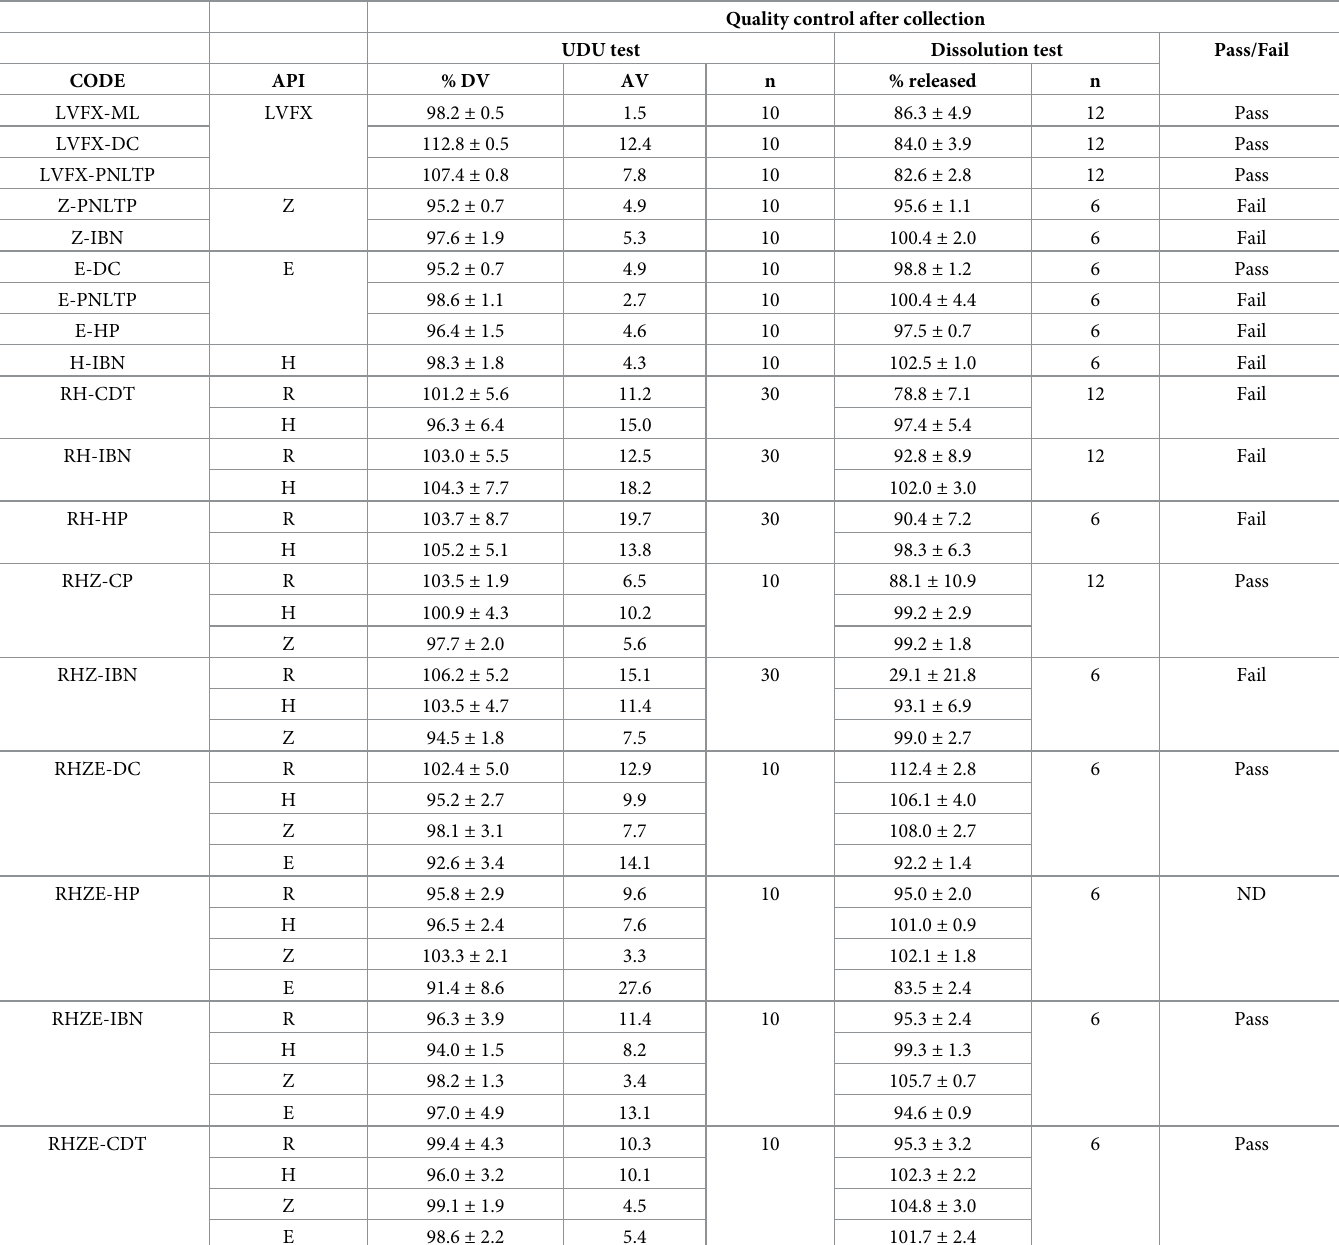
Table 4. Results of uniformity of dosage units and dissolution tests after their